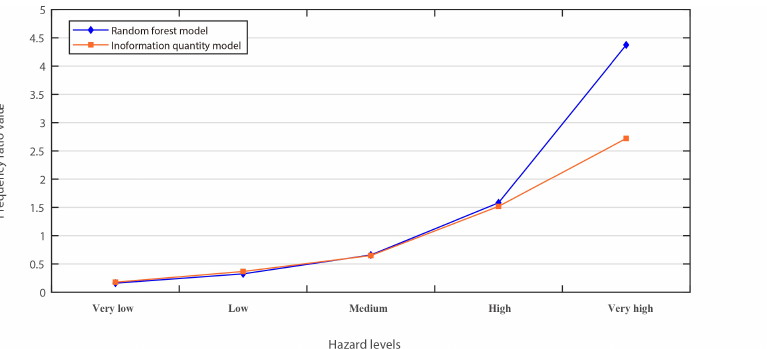
Figure 5. Frequency ratio plot of four hazard levels of RF and information quantity models. Table 1. Distribution of hazard levels overlaying geological disasters of RF and information quan- tity